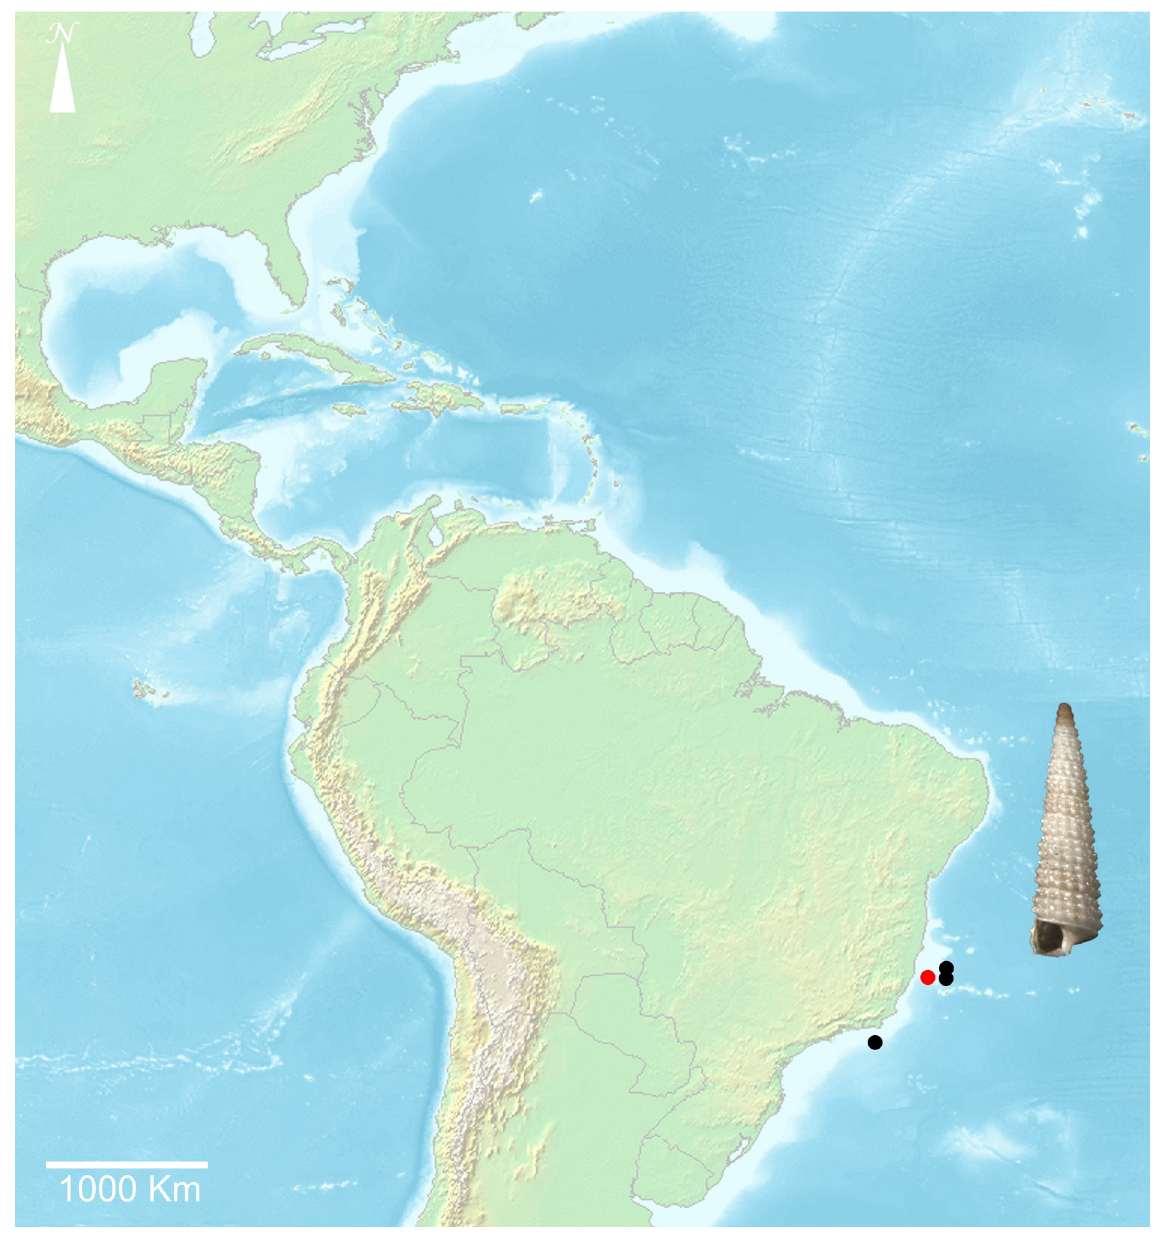
Fig. 68. Distribution map of Strobiligera delicata Fernandes & Pimenta, 2014; red circle = type